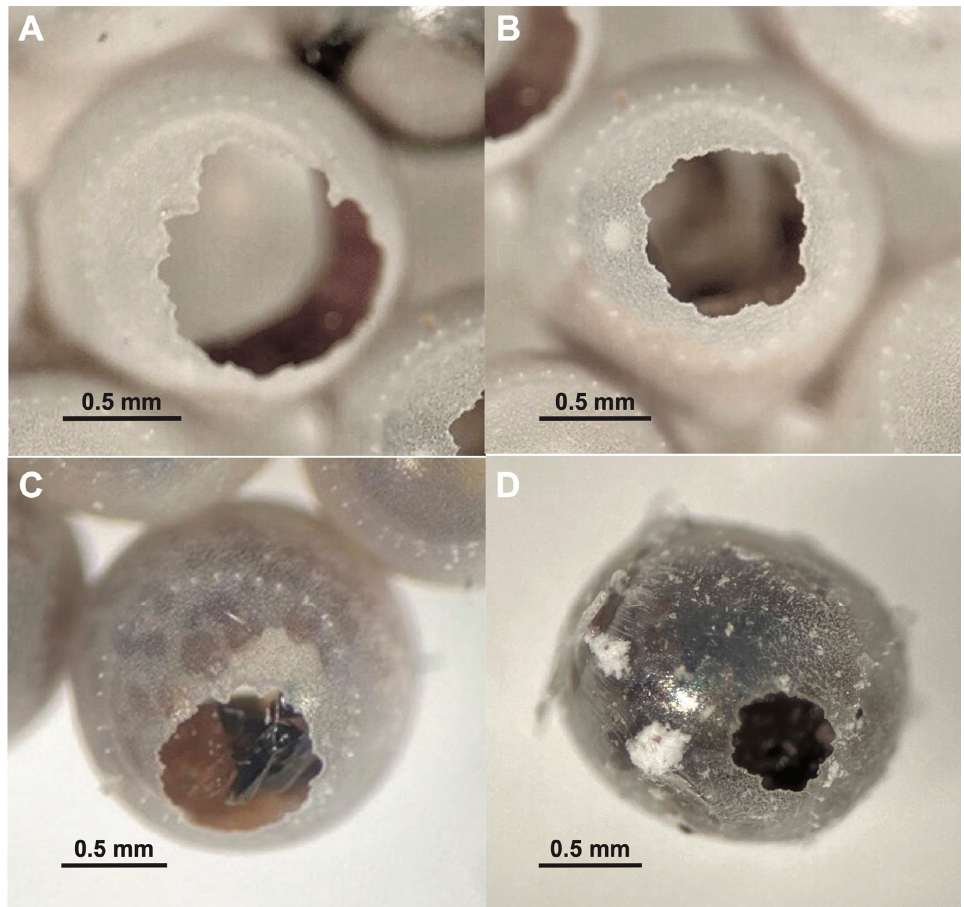
Figure 3. Typical shapes of exit holes produced by egg parasitoids of Halyomorpha halys in Greece: Anastatus bifasciatus female ( A ), and male ( B ), Ooencyrtus telenomicida female ( C ), and male ( D ).